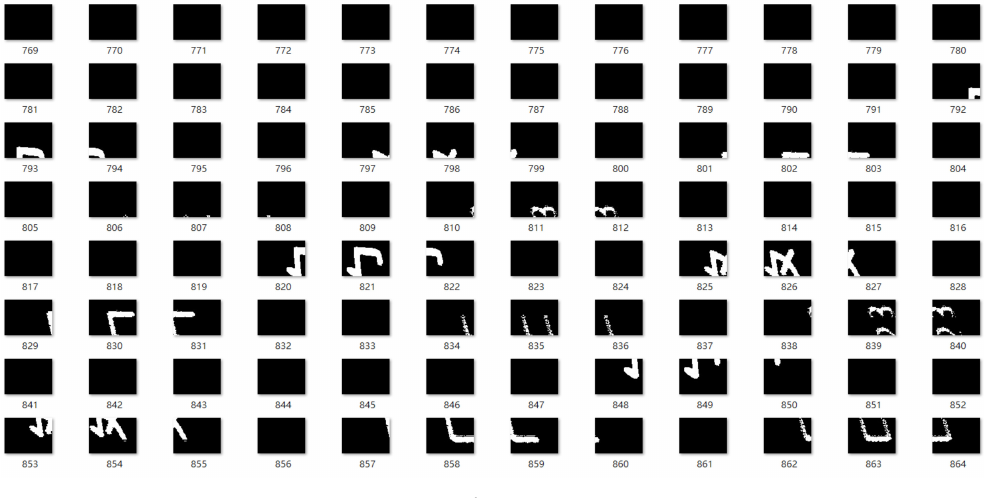
Figure 5. Part B of image preprocessing.